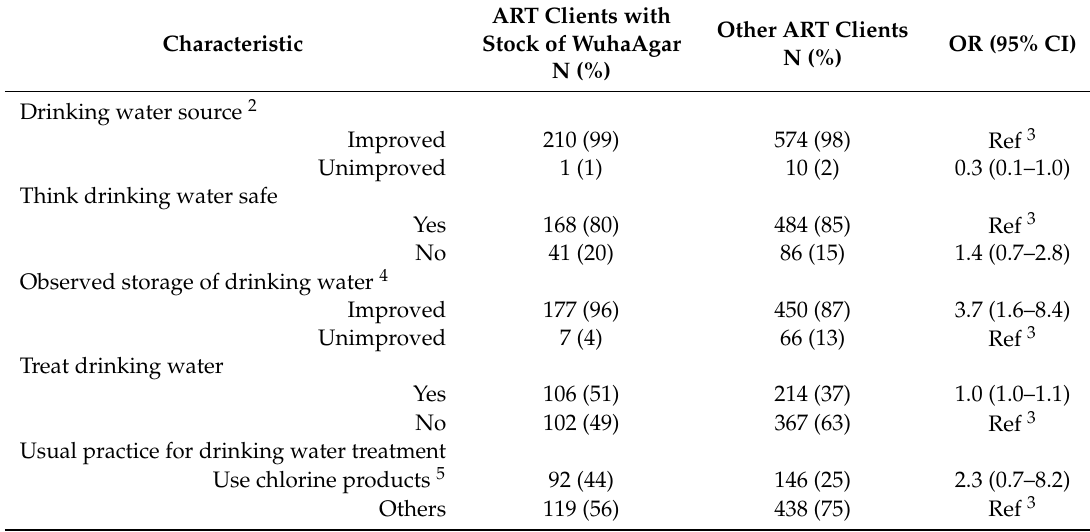
Table 3. Household drinking water source, storage, treatment, and diarrhea incidence, N 1 (%), of ART clients attending clinics with stock of WuhaAgar ( n = 211) and other ART clients ( n = 584), and odds ratio (OR) of being ART client in clinics with stock of WuhaAgar, Ethiopia,